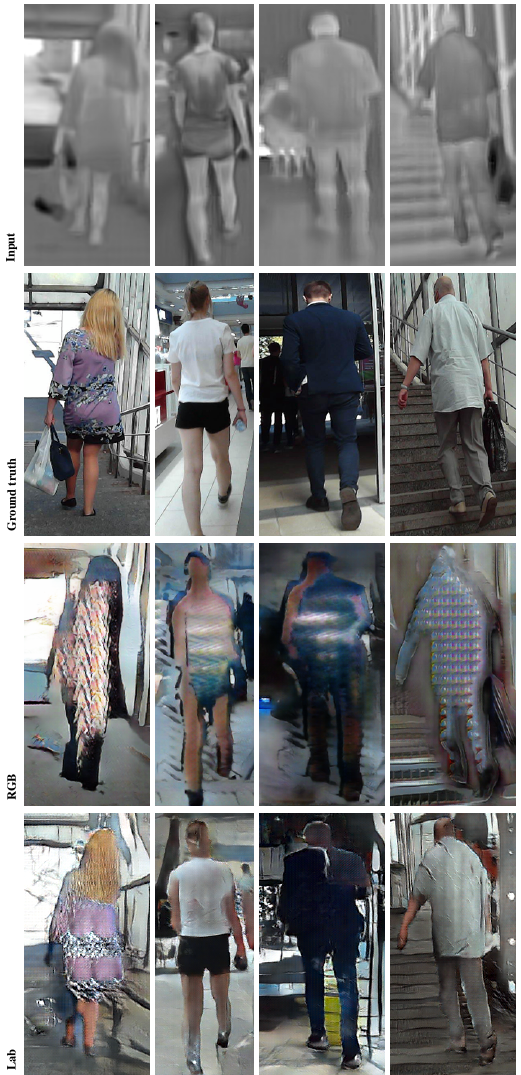
Figure 4. CMC plot and nAUC for evaluation of baselines and ThermalReID method in single-shot setting (top) and multi-shot setting (bottom). Figure 5. Qualitative method comparison . We compare performance of various multimodal image translation frameworks on ThermalWorld ReID dataset. We present colorization results for models trained in RGB and Lab color